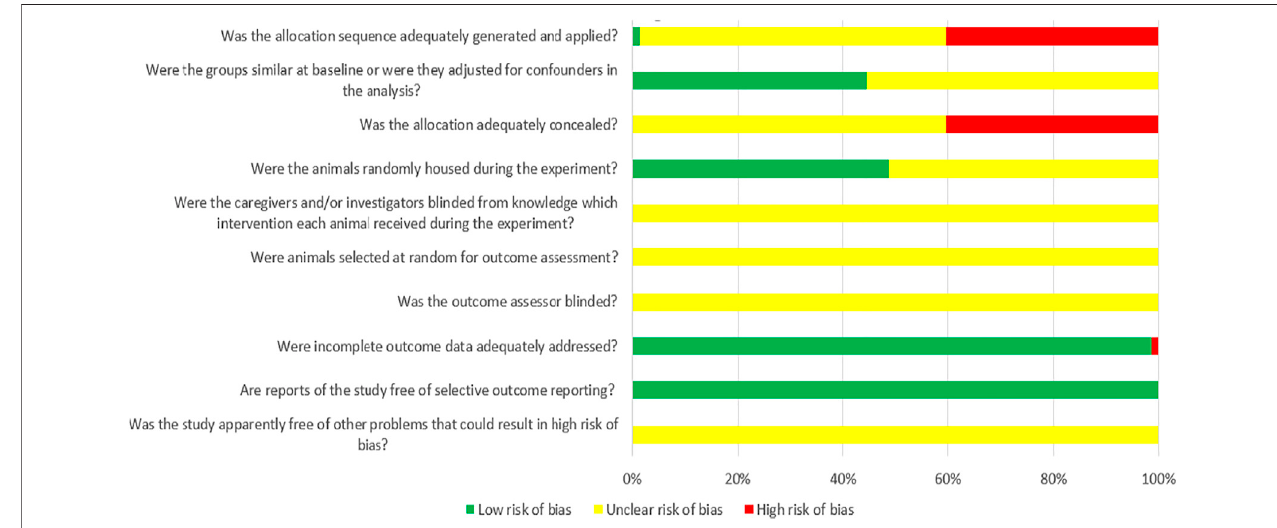
FIGURE2| RiskofbiasofeachitemofSYRCLEtoolforoverallincludedstudies(Eachriskofbiasitempresentedaspercentagesacrossallincludedstudies,which indicated the proportion of different level risk of bias for each item (Hooijmans et al., 2014)).